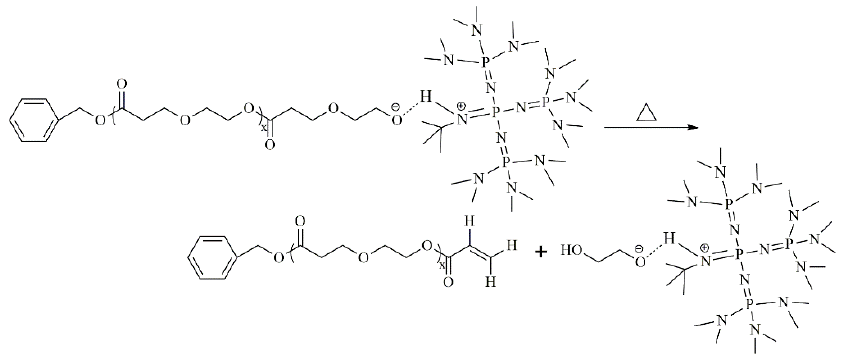
Scheme 2. Suggested ether bond fragmentation pathway during organo-catalytic DXO polymerization.